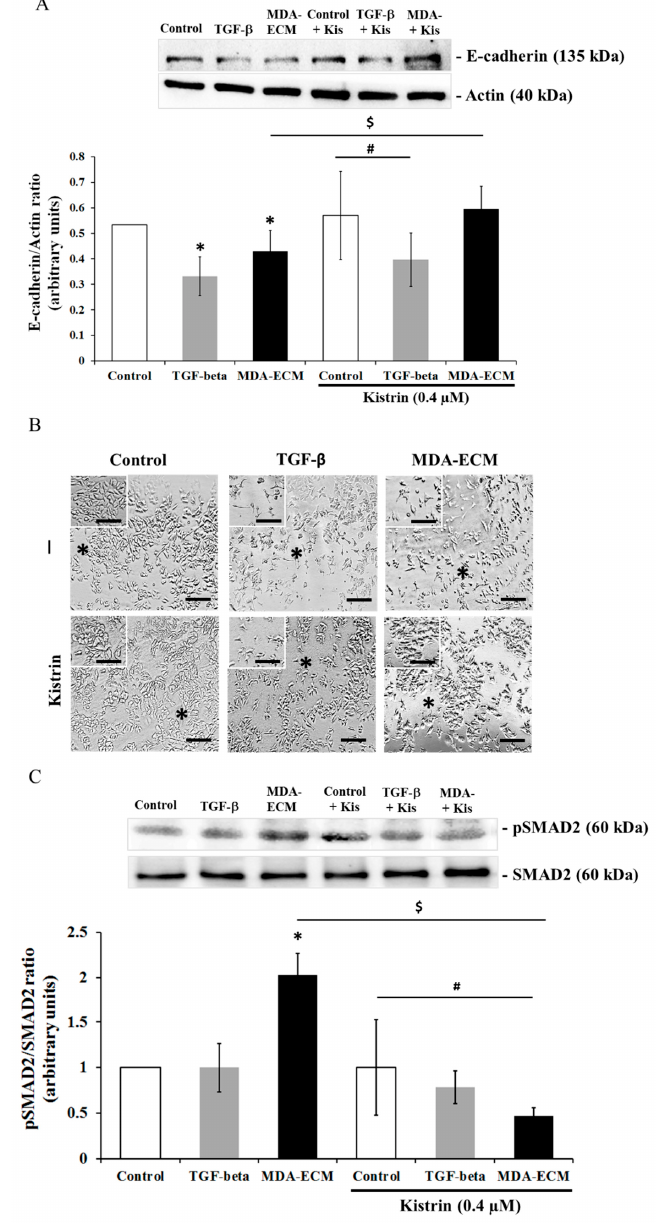
Figure 8. Involvement of integrin α v β 3 in EMT of MCF-7 cells cultured on MDA-ECM. MCF-ECM